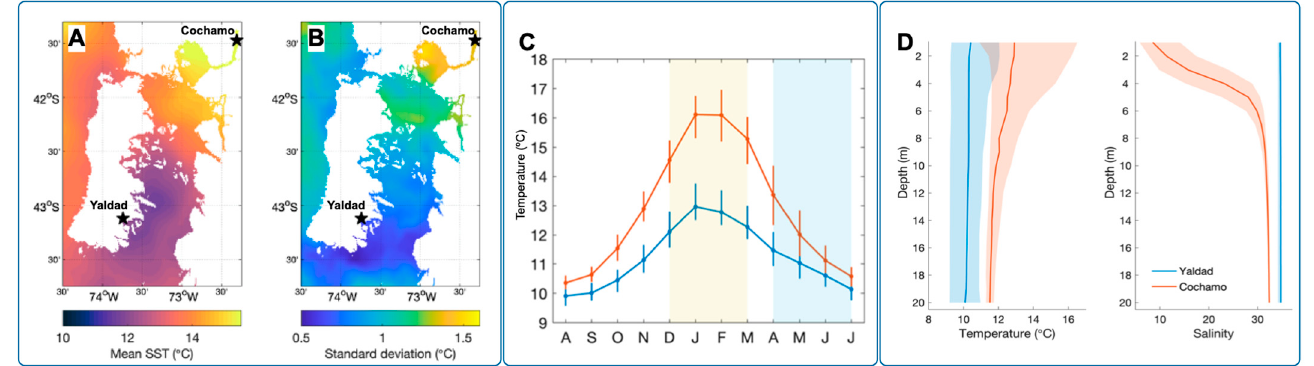
Figure 5. Temporal and spatial variability around Chiloé island, and at the Yaldad and Cochamó sites, over the past two decades. ( A , B ) Maps correspond to mean SST computed for December 2017–March 2018 and the corresponding standard deviations. Stars indicate the location of sampling sites. ( C ) Monthly medians computed from data in ( A ), showing the first and third quartiles as error bars; note that the sequence of months shown on the x -axis begins in August and ends in July. Shaded areas indicate summer (yellow) and fall–winter (blue) periods. ( D ) In situ measurements for temperature ( ◦ C) and salinity (PSU) from 0 to 20 m of depth. The blue and red lines for ( C , D ) represent the data collected from Yaldad and Cocham ó ,